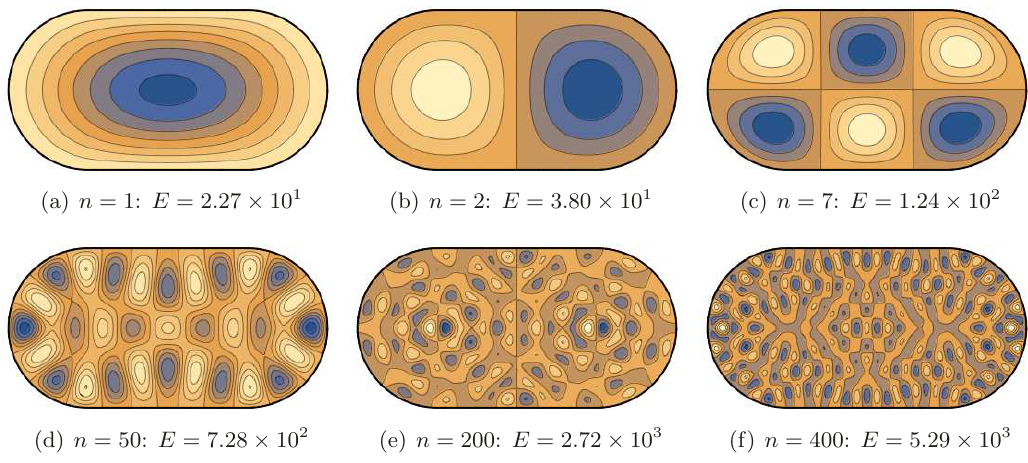
Figure 6 . Eigenfunctions of the quantum billiard with a/R = 1 for n = 1 , 2 , 7 , 50 , 200 , 400. Corresponding eigenvalues are shown below each